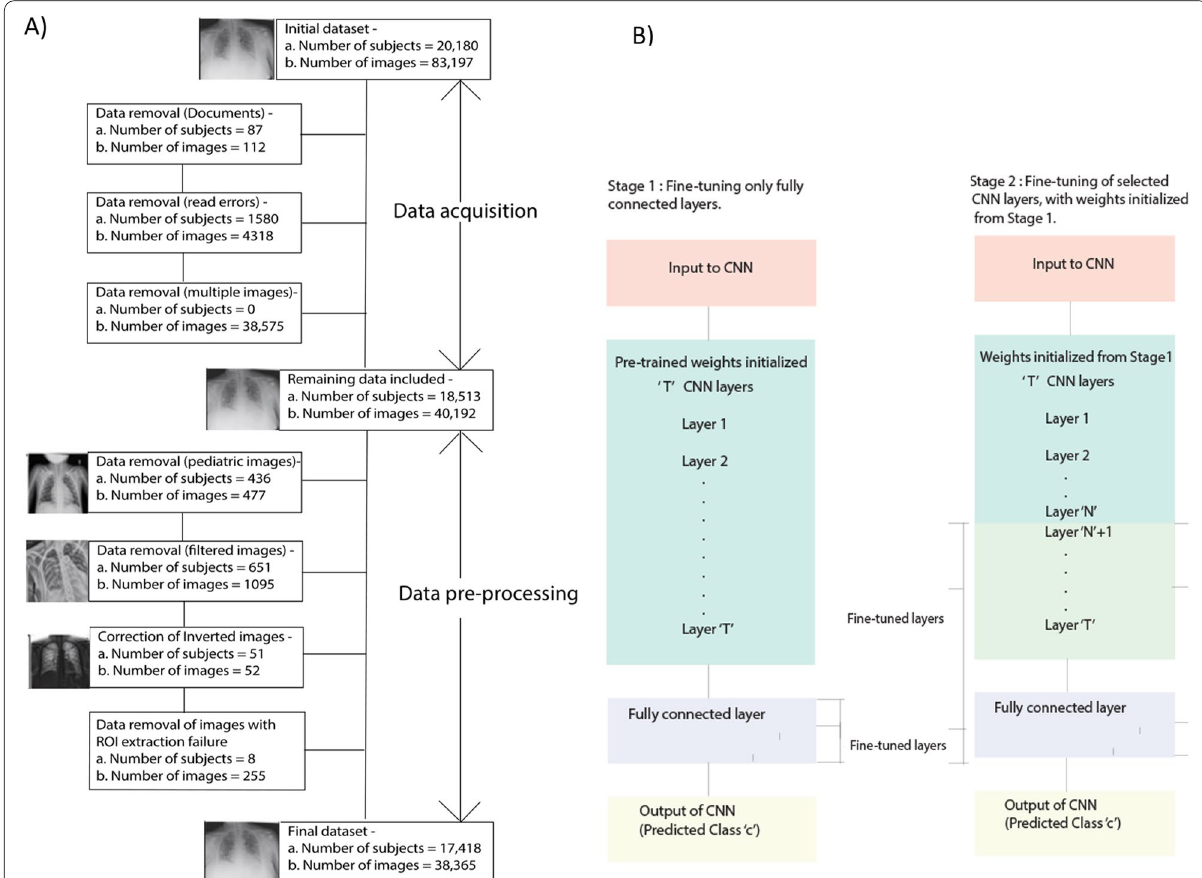
Fig. 2 Schematic of exclusion criteria and transfer learning framework. ( A ) Data exclusion criteria: multiple stages of image acquisition, DICOM to PNG conversion, and application of other exclusion criteria during the data pre-processing stage prior to final data creation; and ( B ) transfer learning framework used to leverage weights from pre-trained models along with our dataset of CXRs with scored opacities. The two different schemes and stages explored using this framework are